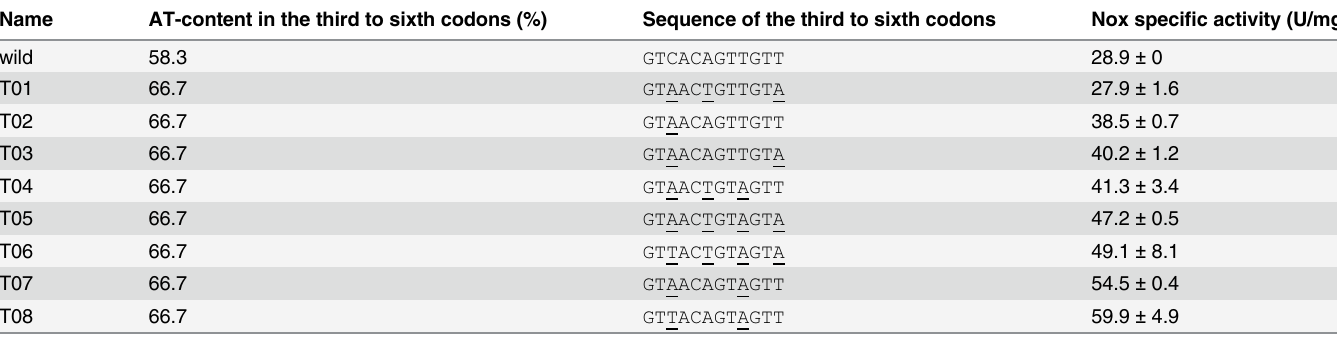
Table 3. Sequences of the third to sixth codons and the Nox